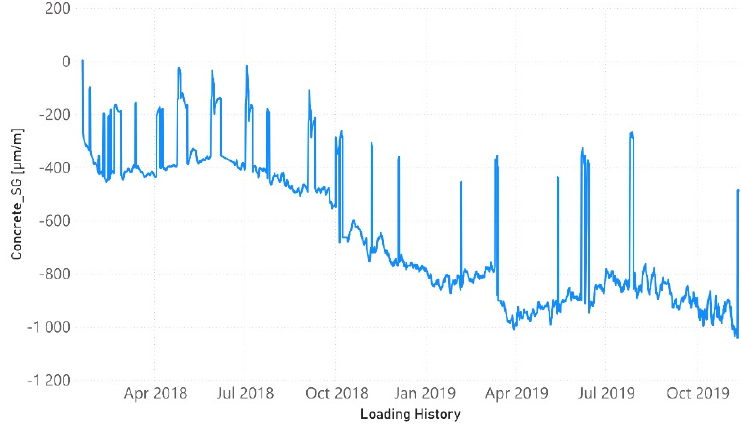
Figure 5. Evolution of compressive strain along the loading history.